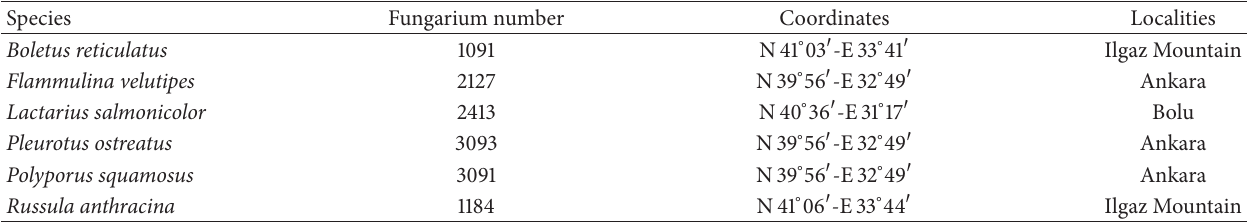
Table 1: Fungarium numbers and locality information of six wild edible mushroom species.